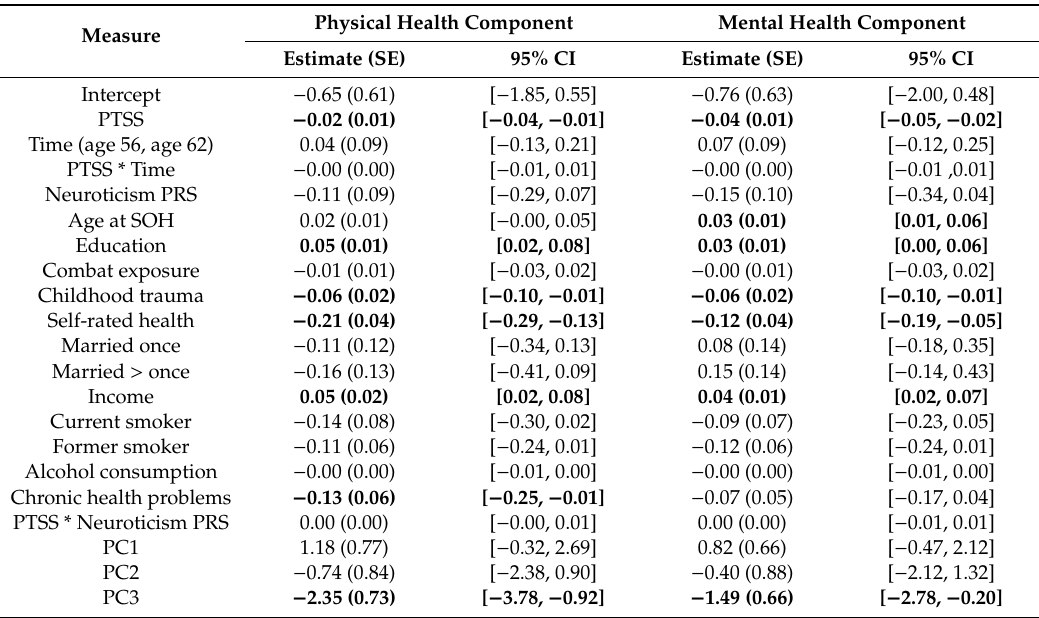
Table 2. Age 38 Characteristics and Physical and Mental HRQOL Component Scores at Midlife in Trauma-Exposed Men (Type 3 tests of fixed e ff